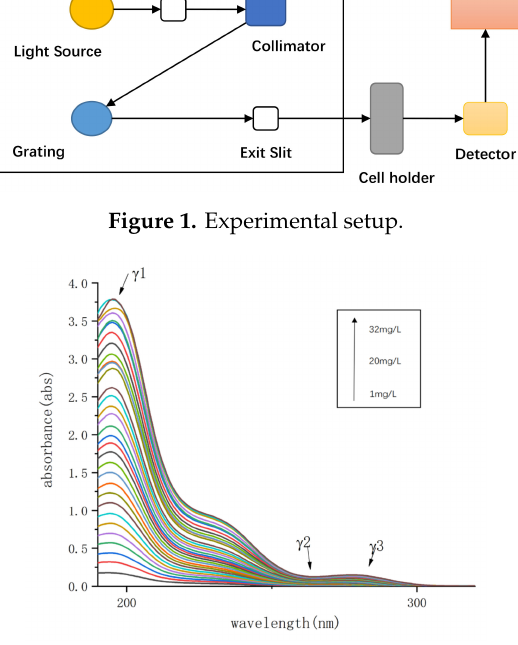
Figure 2. Full spectra of UV absorbance of COD solutions with di ff erent concentrations, where γ 1 is the first extreme point, γ 2 is the second extreme point, γ 3 is the third extreme point.